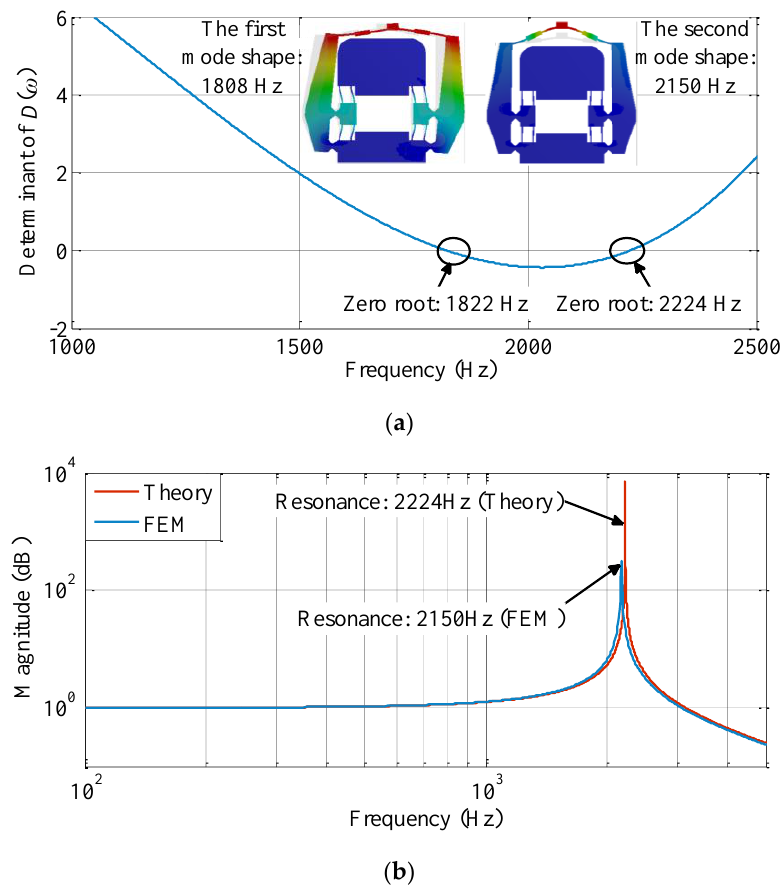
Figure 9. Dynamic bandwidth of the displacement amplification mechanism provided by the two-port dynamic stiffness model and finite element software package ANSYS Workbench 15.0. ( a ) Searching the zero roots of the determinant of the dynamic stiffness matrix D ( ω ) and the finite element results of mode shapes. ( b ) The dynamic response spectrum of the output